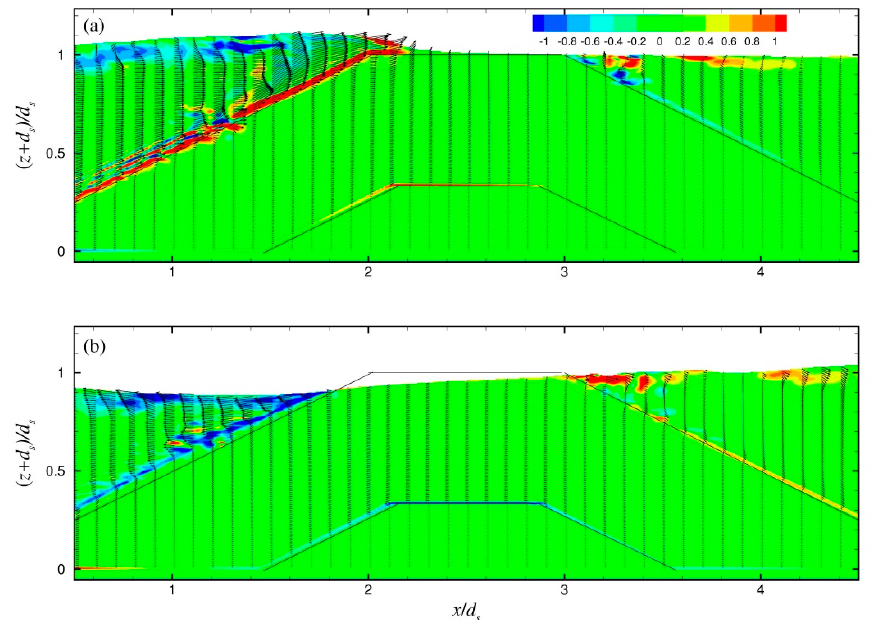
Figure 16. Shear stress for case 5 at two instants during the 30th wave period: ( a ) T / 2, and ( b ) T .